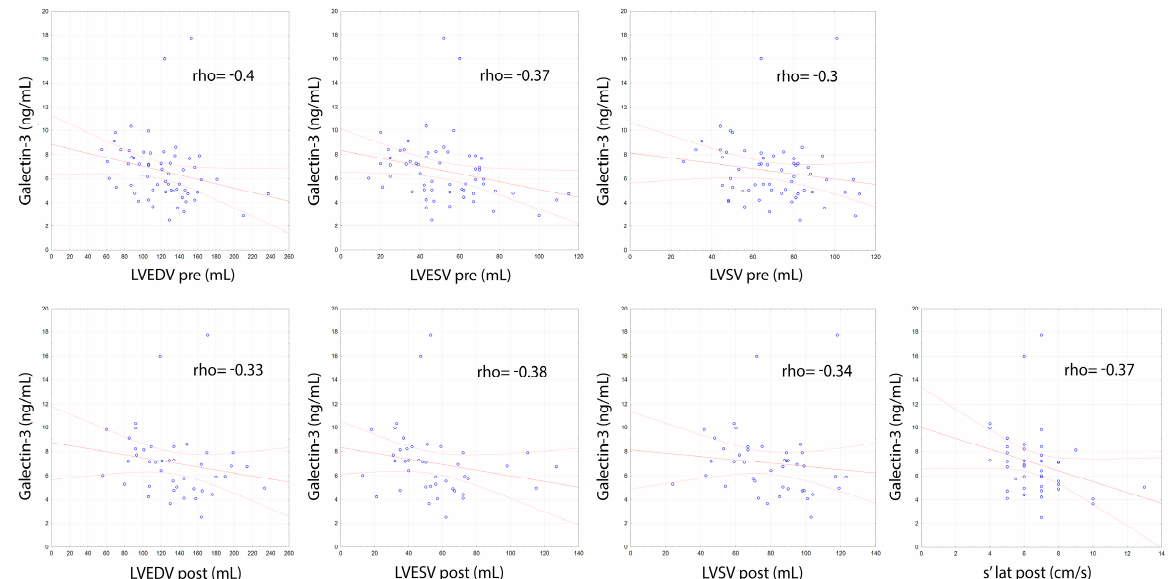
Figure 3. Correlations of galectin-3 concentration with echocardiographic measurements assessing left ventricular volume and